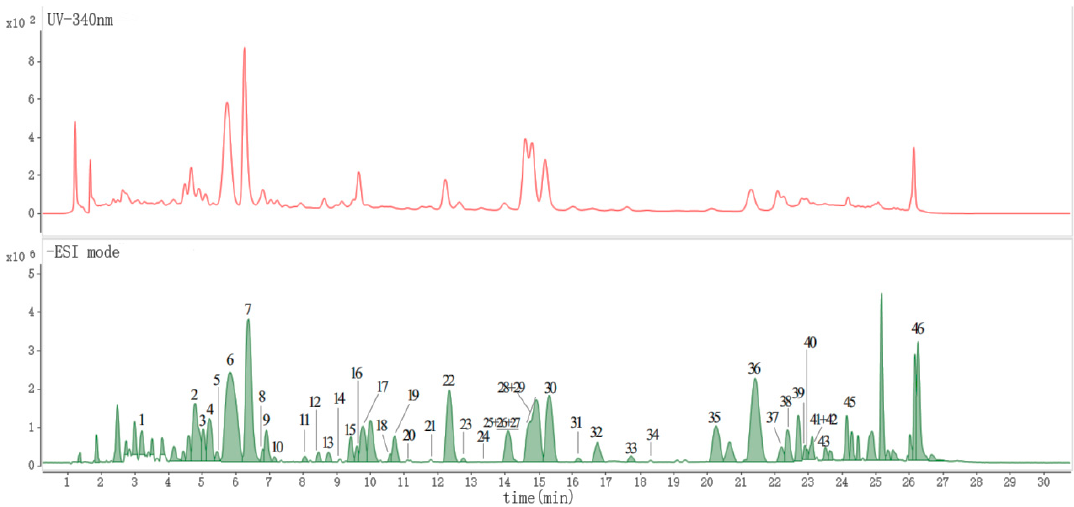
Figure 2. UPLC ‒ UV chromatogram (340 nm) and UPLC-ESI-QTOF-MS/MS base peak chromatogram (BPC) in negative ESI mode of OHPLE.